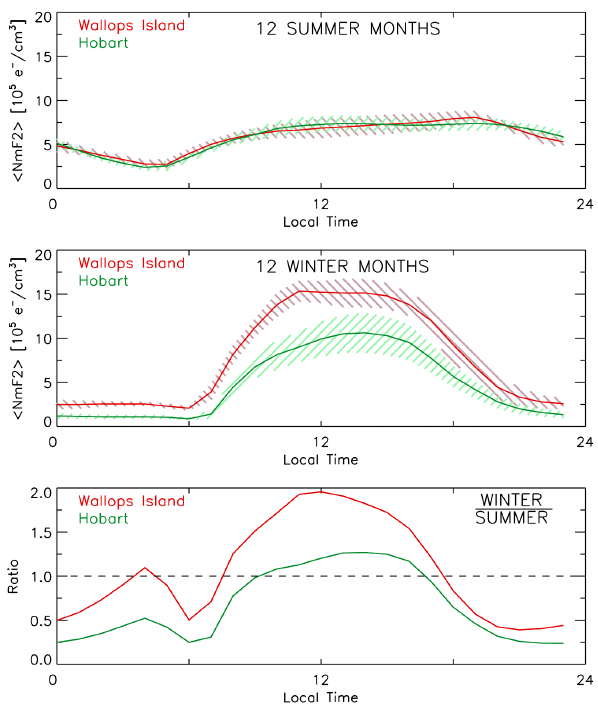
Fig. 12. Comparisons of average conditions for summer and winter months at Wallops Island and Hobart during solar maximum years. Panel (a) gives the average diurnal pattern formed from the May– August (Northern Hemisphere summer) months of 1968–1970 at Wallops Island in comparison to the average diurnal pattern from the November–February (Southern Hemisphere summer) months of 1968–1970 at Hobart. Panel (b) gives the average patterns for the reversed cases of winter months at Wallops Island and Hobart. Panel (c) gives the ratio of Winter/Summer patterns at each station to characterize the difference in seasonal anomaly magnitudes in each hemisphere, called the hemispheric